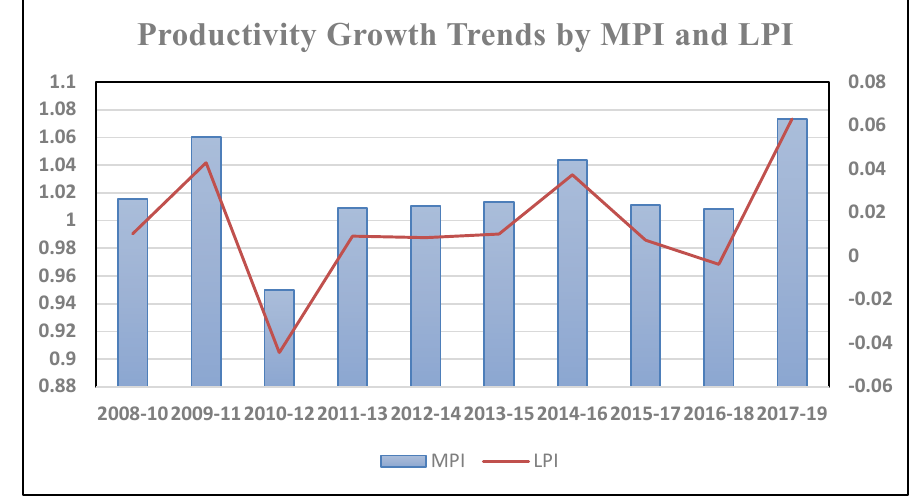
Fig. 1 . Trends of IMPI and LPI Values for Depots Over the Period